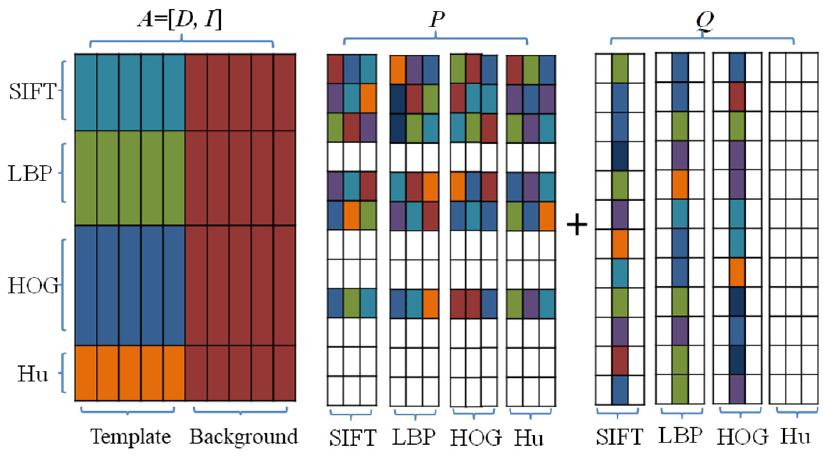
Figure 8. The structure of the matrices P , Q , and A. It should be noted that the superposition of P v and Q v requires the same number of columns as A v , so the zero matrix is used to fill the A v matrix. Definition ˆ A v = [ A v , 0 v ] , where 0 v ∈ (cid:60) dv × ( n 1 − n v ) , and each element of 0 v is zero, n 1 , . . . , n v is the dimension of each